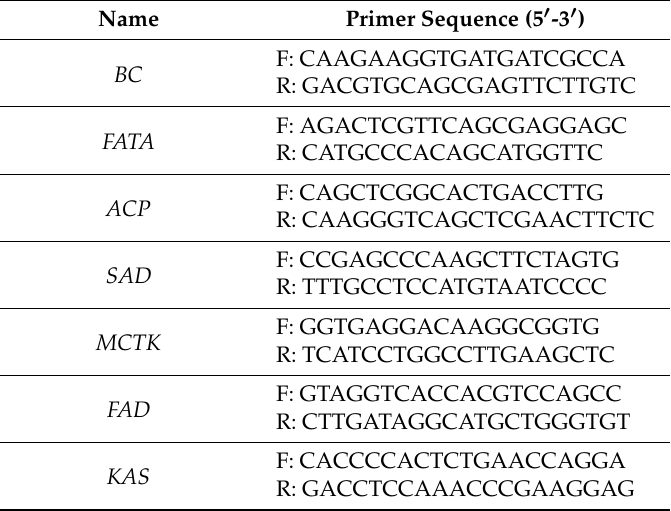
Table 3. Genes and primer